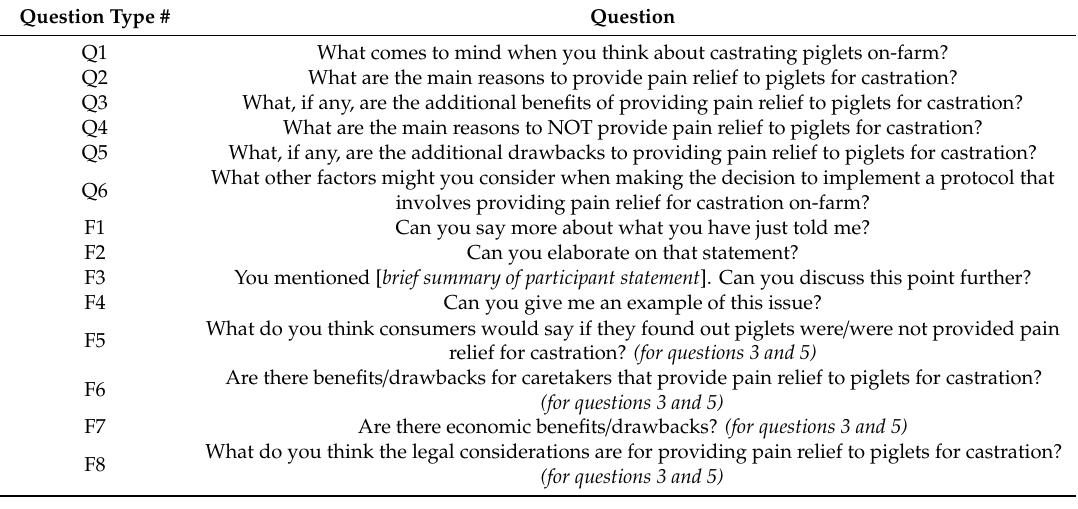
Table 1. Primary (Q) and follow-up (F) questions utilized in focus group discussions on piglet castration and pain relief on swine farms in the United